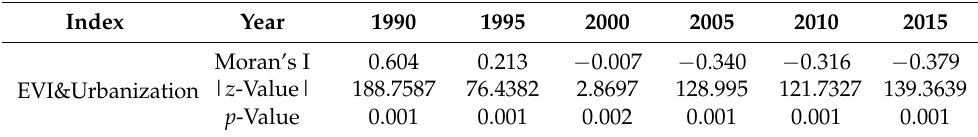
Table 3. Moran’s I index and significance test results of Shannan City’s EVI and urbanization levels from 1990 to